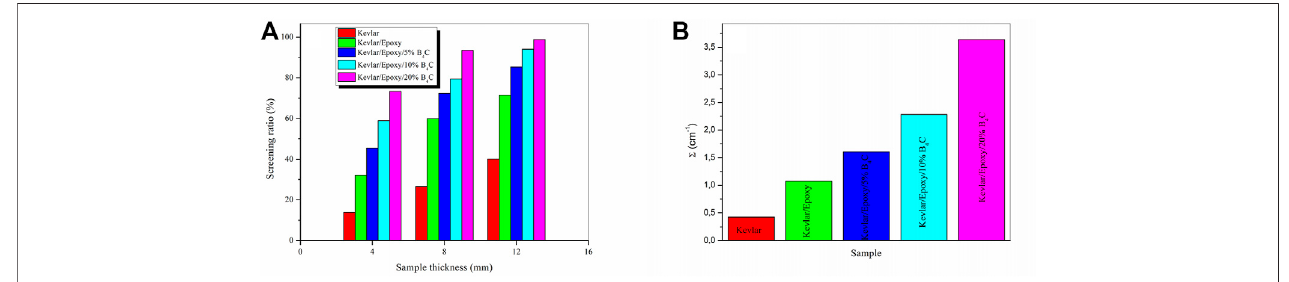
FIGURE 3 | Evolution of the screening ratios and the neutron attenuation coef fi cients.